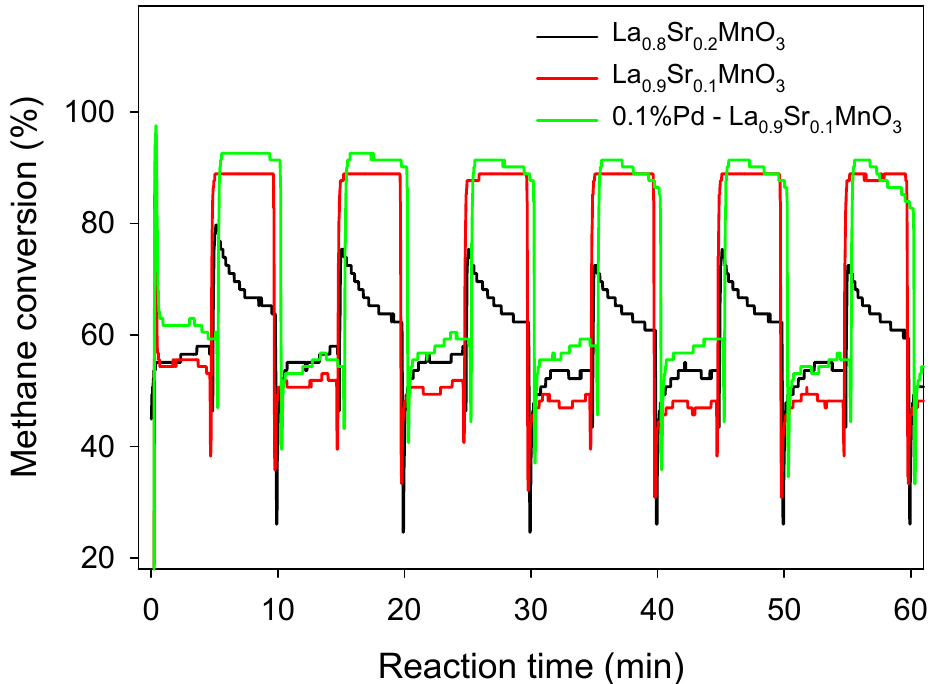
Figure 4. Methane conversion of La 0.8 Sr 0.2 MnO 3 , La 0.9 Sr 0.1 MnO 3 , and 0.1%Pd-La 0.9 Sr 0.1 MnO 3 catalyst. Start-up conditions: methane inlet concentration: 0.8%, reaction temperature: 800 °C, inlet flow velocity: 1.2 m 3 /h, switch time: 5 min.